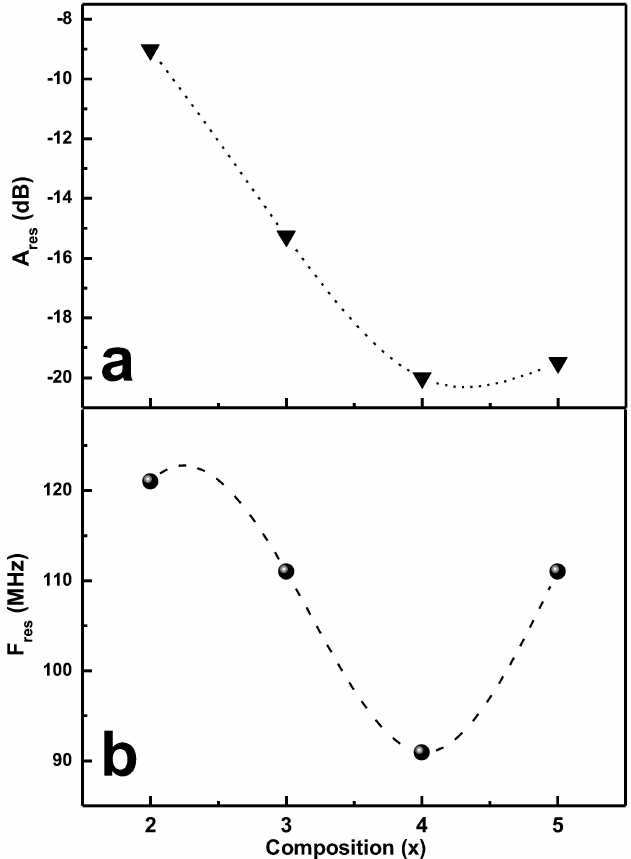
Figure 11. Composition dependencies of the resonant amplitude − A res (a) and resonant frequency − F res (b) for S r0.3 Ba 0.4 Pb 0.3 Fe 12 O 19 /(CuFe 2 O 4 ) x composite samples (x = 2, 3, 4 and